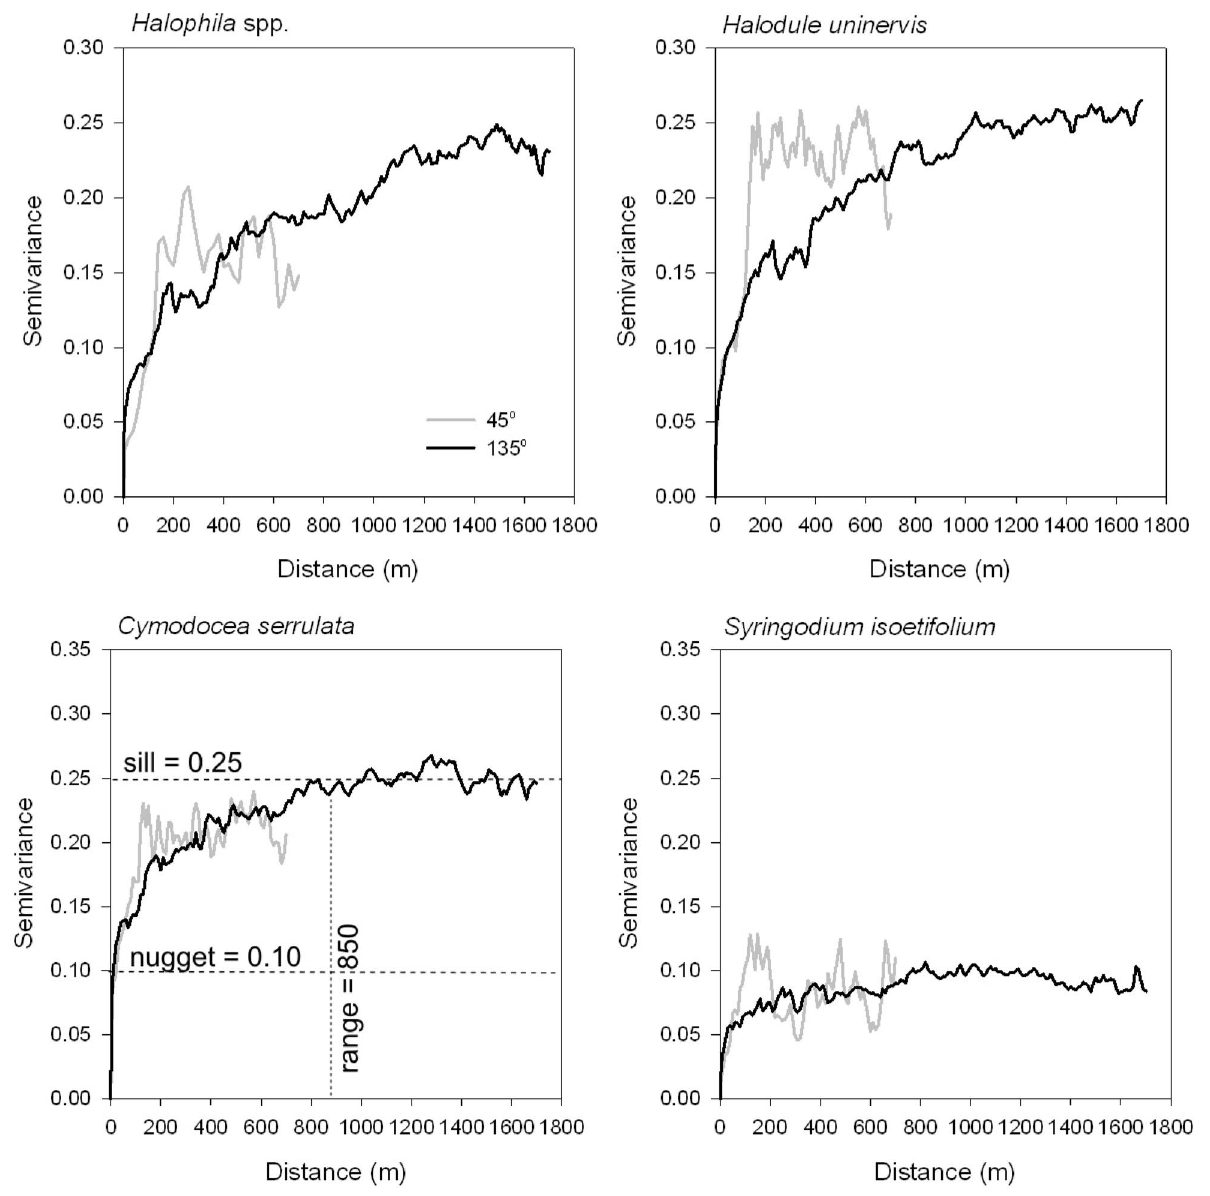
Figure 2. Directional variograms for presence/absence of four seagrass species in the along-shore (135 u ) and across-shore (45 u ) of Pulau Tinggi, Peninsular Malaysia. Other directions (0 u =north-south and 90 u =east-west) were modeled but are not shown. Variograms were plotted for half the maximum distance between points in each direction, lag 10 m, tolerance 5 m. The theoretical variogram structures (nugget, range and sill) are shown for Cymodocea serrulata.